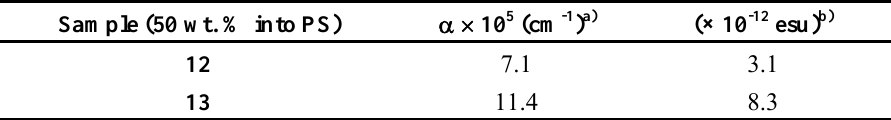
Table 1.  (3) Values. Fundamental wavelength: 1260